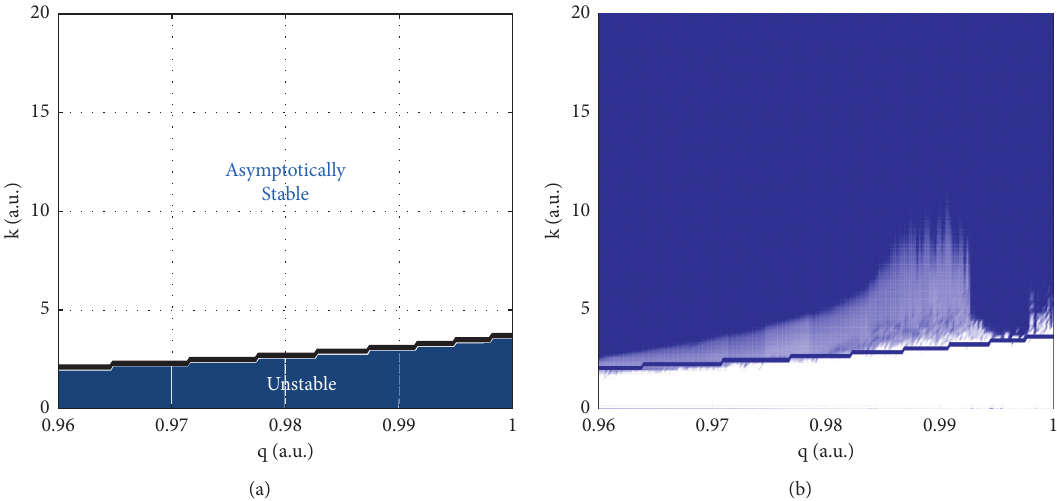
Figure 5: (a) Stability analysis from linear error dynamics for the coupled R ¨ ossler system shown in equation (21). (b) Overlap of the analytical result in the synchronization map shown in Figure 4(a).